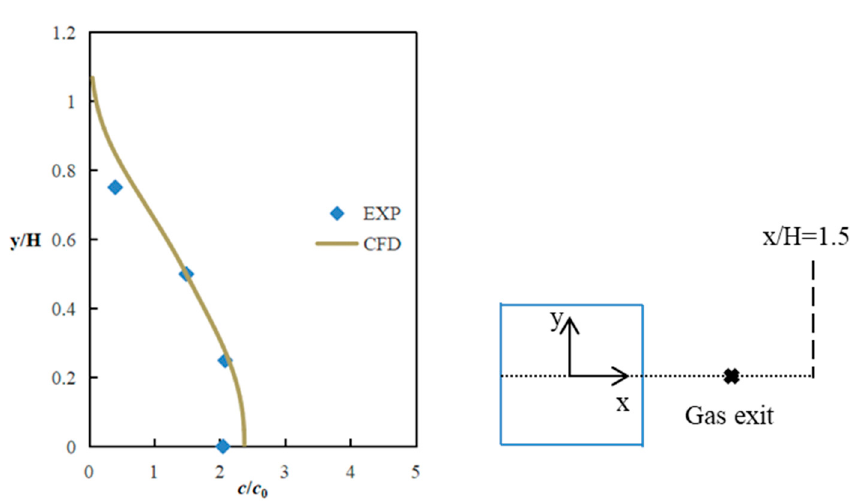
Figure 4. Comparison of the normalized pollutant concentrations at horizontal profiles at a half building height (z/H = 0.5).